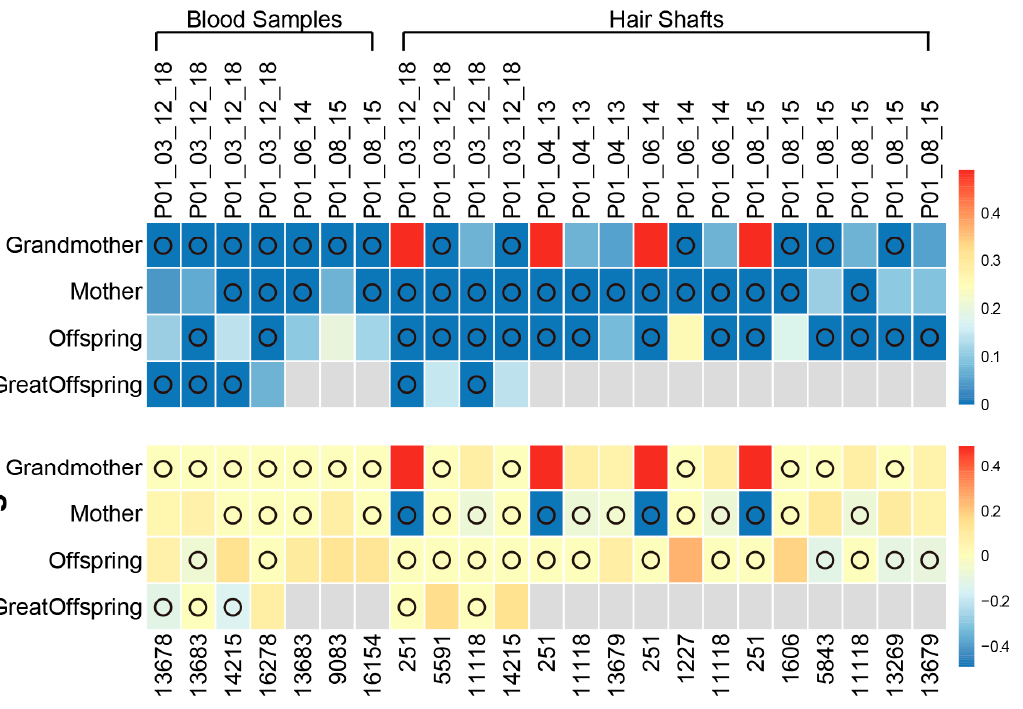
Table 6. Di ff erent mtGenome haplotypes in ten types of maternal relationships.